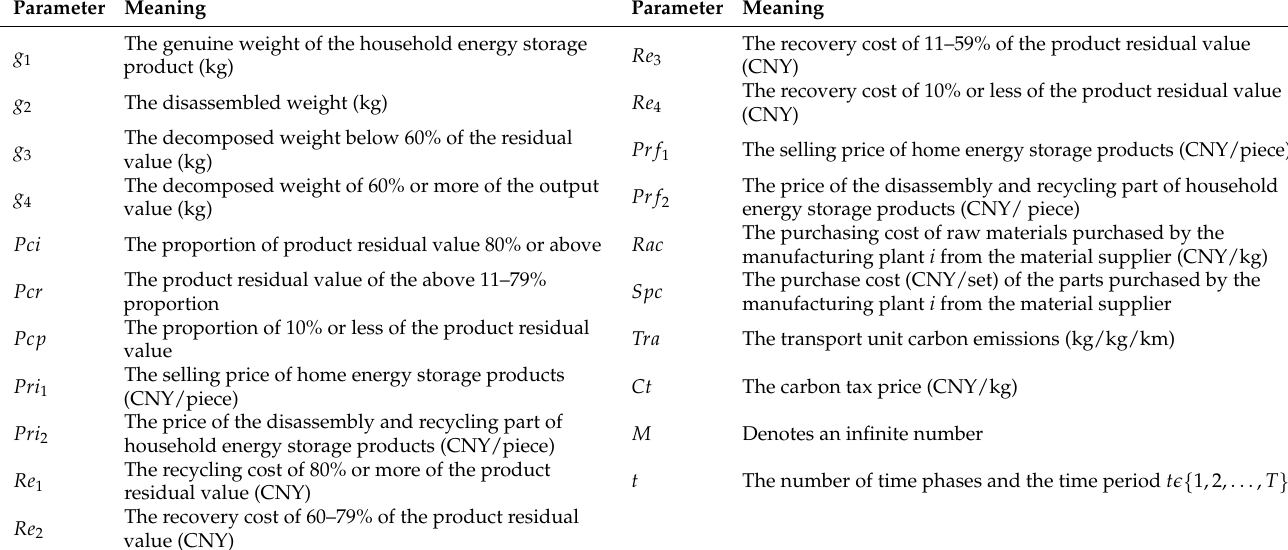
Table 9. Other relevant